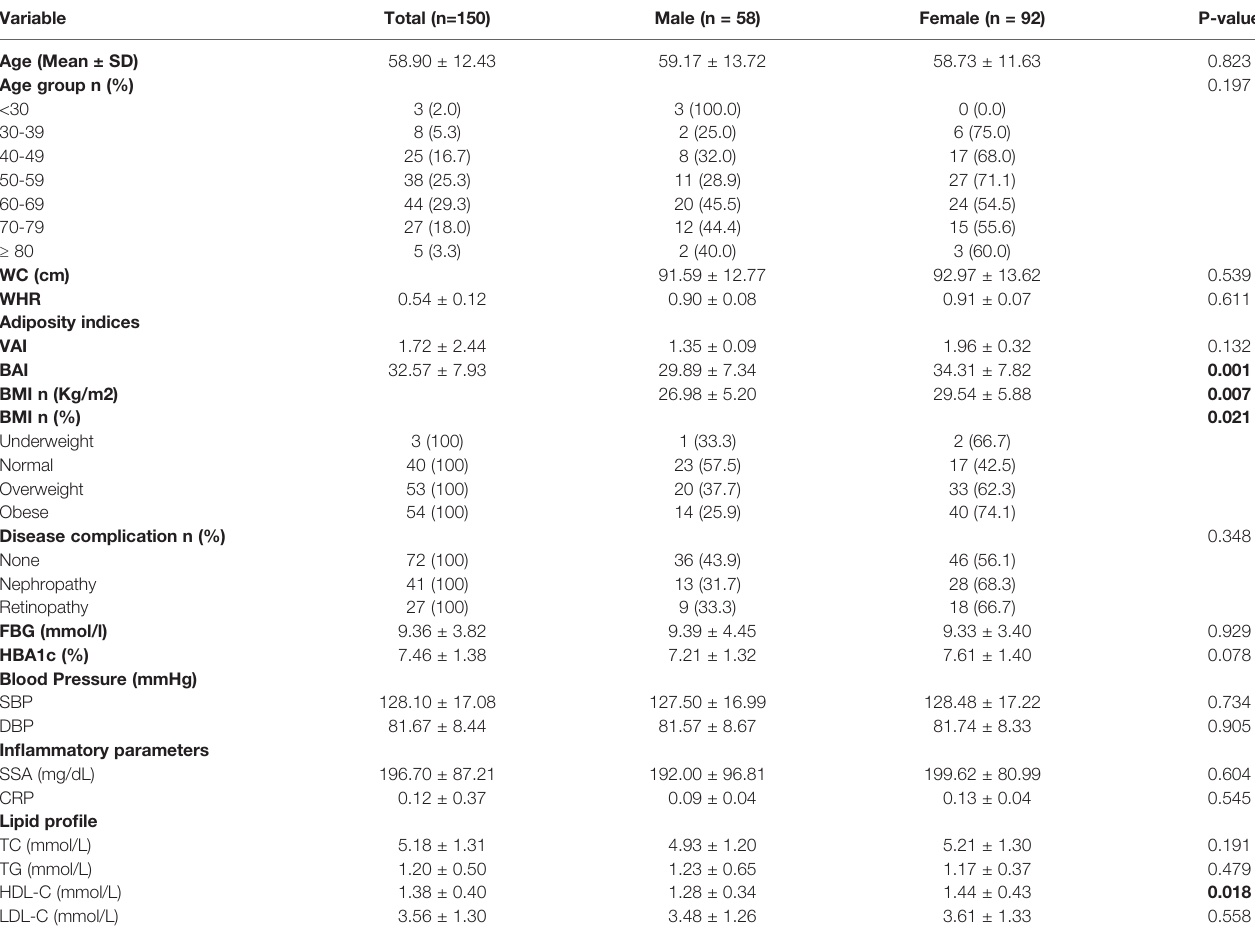
TABLE 1 | Demographic and clinical parameters of study participants as strati fi ed by gender.